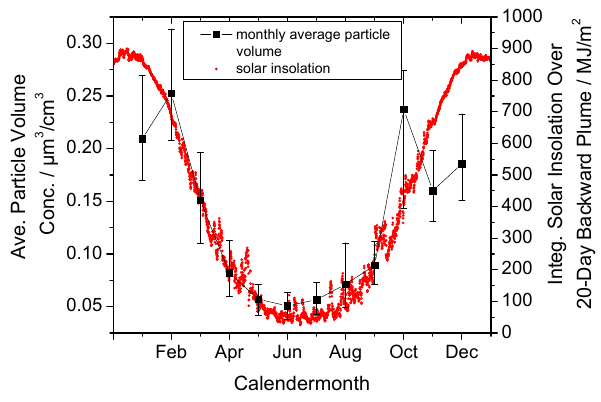
Fig. 9. Monthly average particle volume concentration (integrated over particle size) based on the particle number size distributions in baseline air masses observed at Troll in the 2007–2011 time period (black squares). Also plotted for comparison is the average solar insolation on the air masses arriving at Troll integrated along the 20-day backward plume, as calculated by FLEXPART for the year 2010.